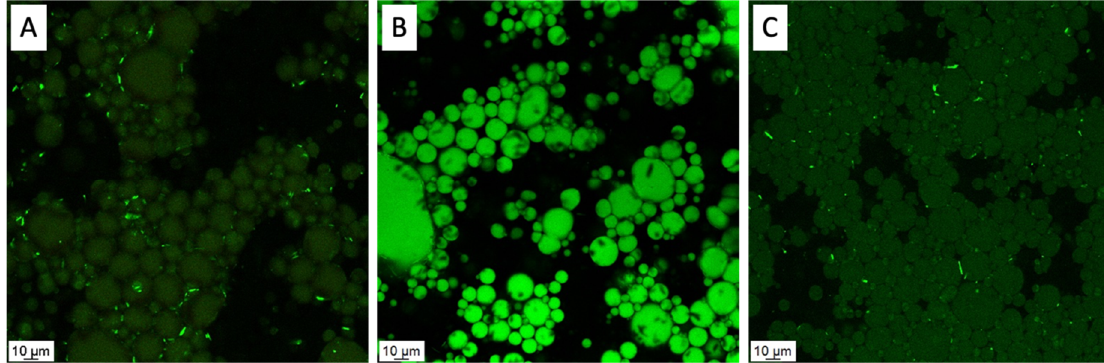
Figure 2. Confocal microscopy images showing the natural fluorescence of curcumin included in the KC1 particles of KC1 φ 0.4 (4.7%) sample ( A ), KC2 particles of KC2 (KC2 φ 0.4 (4.7%) ( C ), and the fluorescence of the oil phase stained with Nile red of the sample KC1 φ 0.4 (4.7%) ( B ).